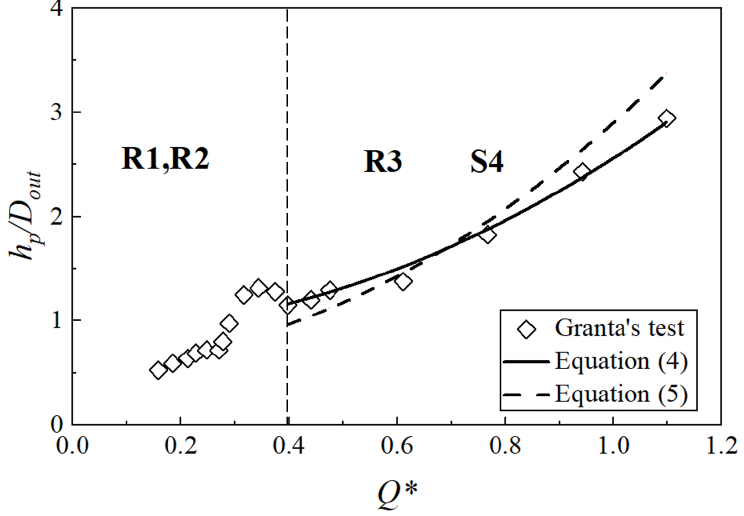
Figure 6. Dimensionless water level versus discharge for D M =1.0 m, D out = 0.2 m, s =1.5 m and jet opening plate of